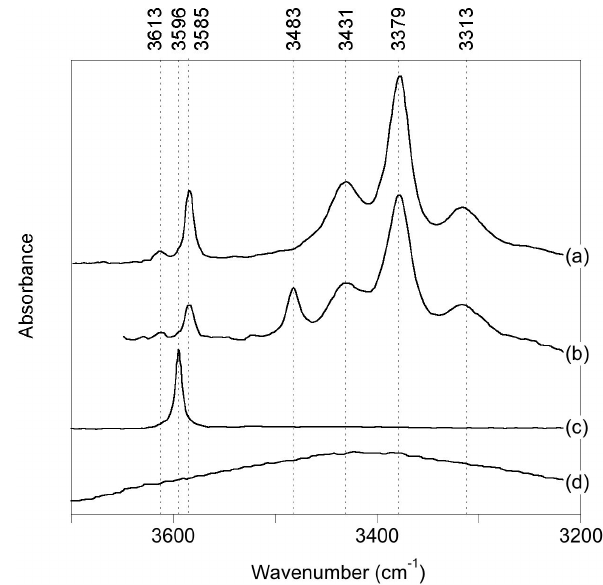
Figure 1. Experimental spectra of quartz samples display- ing commonly observed OH-stretching bands (a) : Stalder and Konzett (2012), sample pH32 (polarized E ⊥ [001]-E || [001]); (b) : Frigo et al. (2016), 10% spodumene, 1.0GPa (polarized E ⊥ [001]- E || [001]); (c) Thomas et al. (2009), B-doped quartz (unpolarized); (d) Potrafke et al. (2019), (polarized E || [001]).